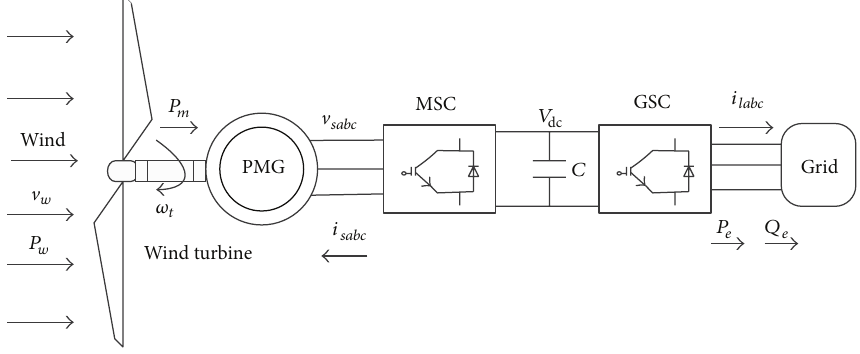
Figure 2: The model of direct-drive wind